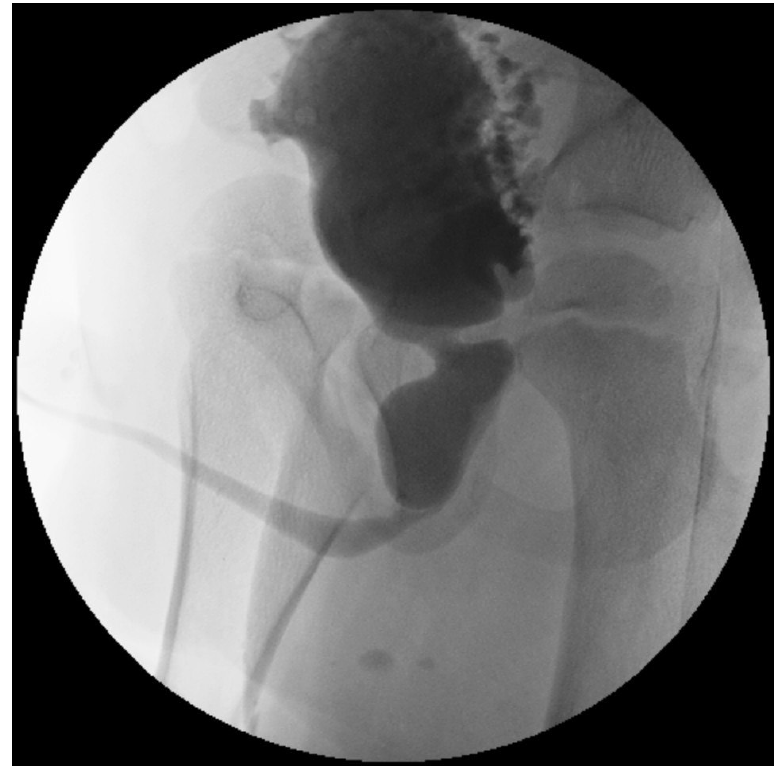
FIGURE 2 . A voiding cystourethrogram demonstrating the trabeculated bladder, dilated posterior urethra, and valve leaflets typical of